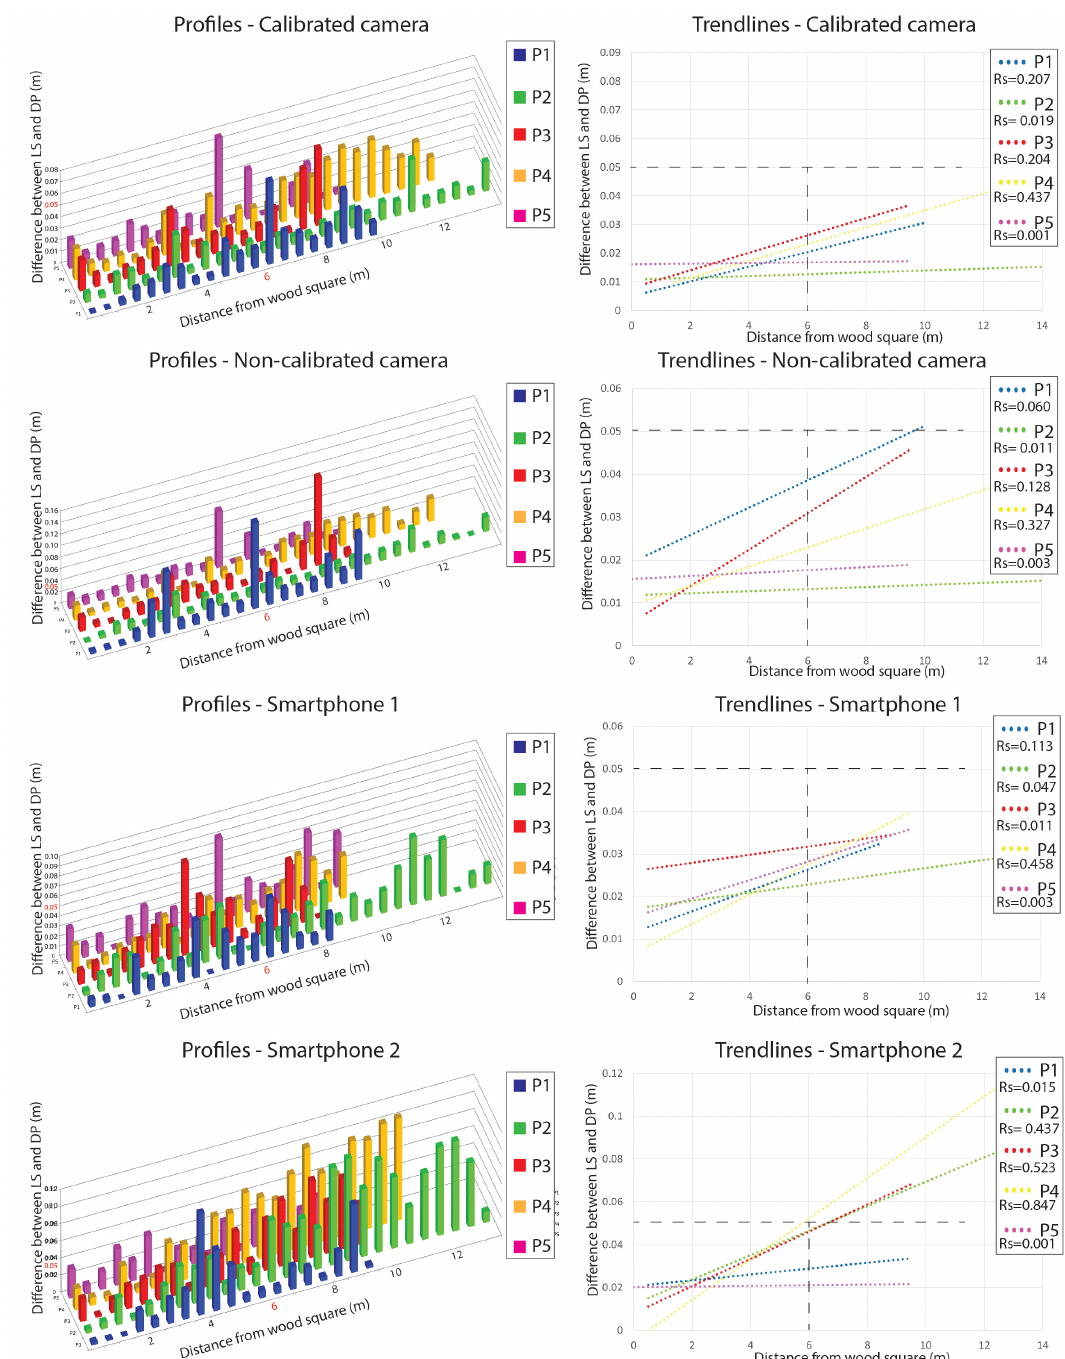
Figure 11. Dispersion graphs (left) and trendline graphs (right) obtained from the comparison between the models from the LS and calibrated camera, non-calibrated camera, smartphone 1 and smartphone 2. All models were georeferenced using the three targets 1, 2, and 3. For references, we have included the black dashed lines in the trendline graphs at a distance of 6 m from the wooden square and for indicating a 0.05 m di ff erence between the LS and DP. In the column charts, 6 m of distance and 0.05 m of di ff erence were highlighted in red. Rs in the trendline graphs indicates the R square